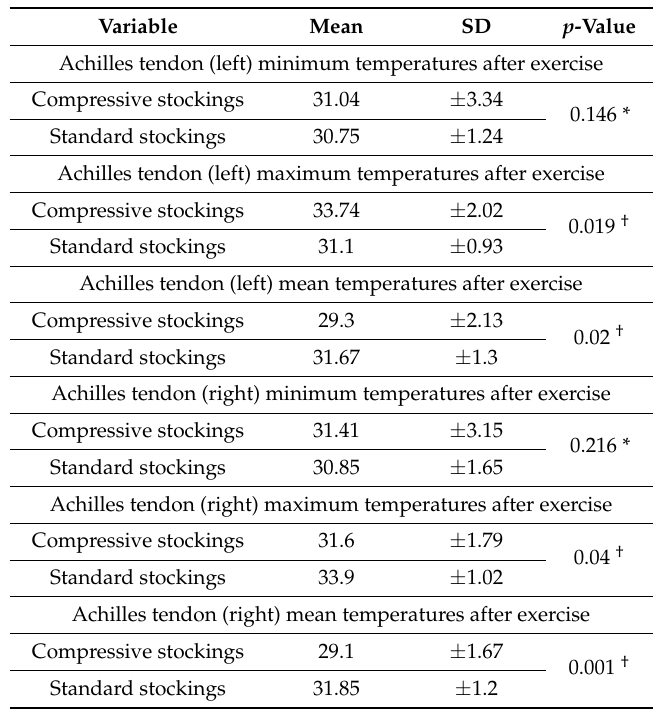
Table 3. Temperature values (degrees Celsius) for Achilles tendons in compressive stocking and standard stocking participants after